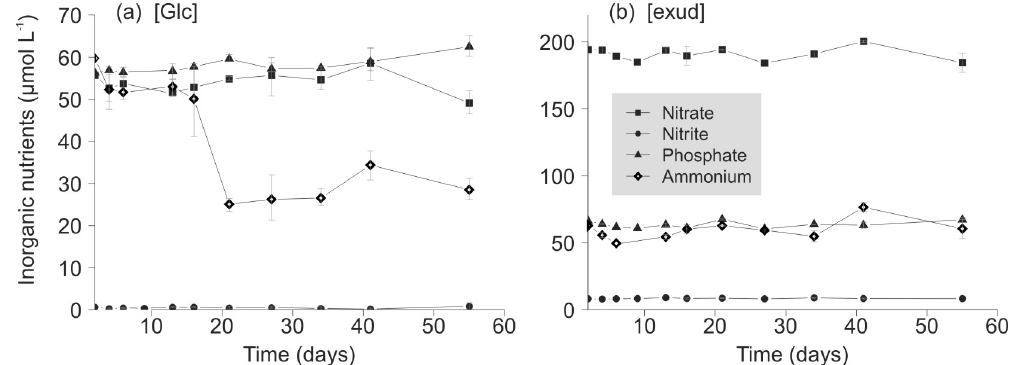
Figure 5. Inorganic nutrients: concentration of nitrite, ammonium, phosphate and nitrate during the incubation period. Changes are displayed as averages for (a) [Glc] treatments ( n = 3) and (b) [exud] treatments ( n = 2). Error bars represent the range of values. Changes in [ 13 Glc] treatments (not shown) were almost identical to [Glc]